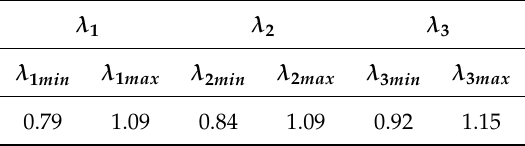
Table 10. The max and min value of the three parameters in adjustment.